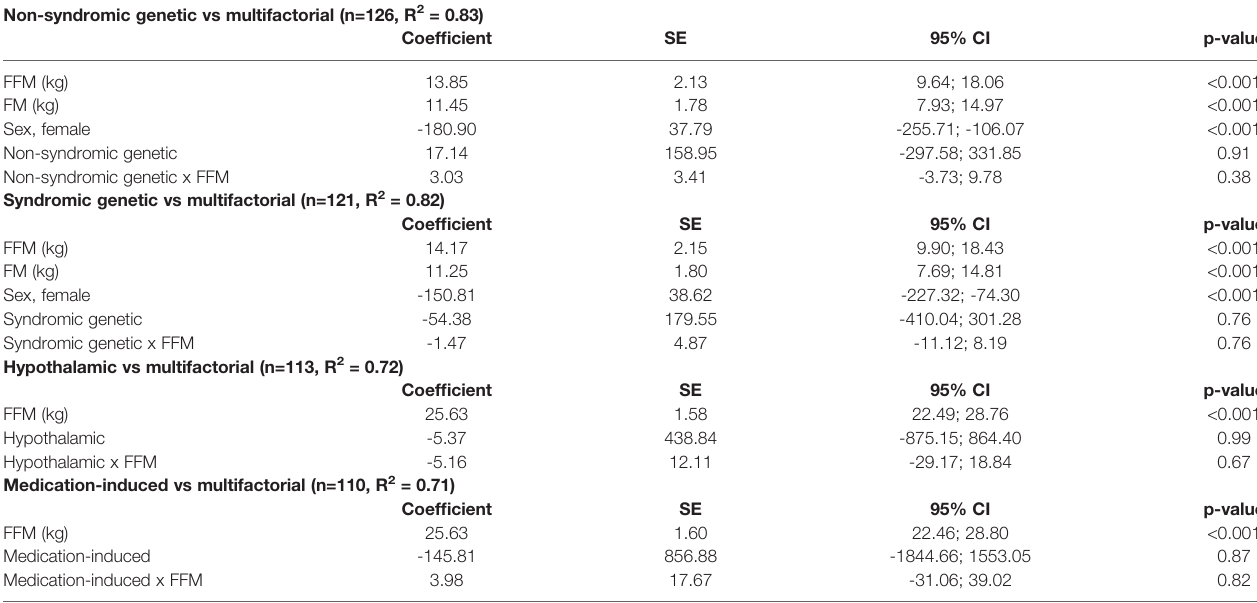
TABLE 4 | Results of multiple regression analyses on differences in mREE (kcal/day) between patients with each of the underlying medical causes versus multifactorial obesity. Non-syndromic genetic vs multifactorial (n=126, R 2 = 0.83) Coef fi cient